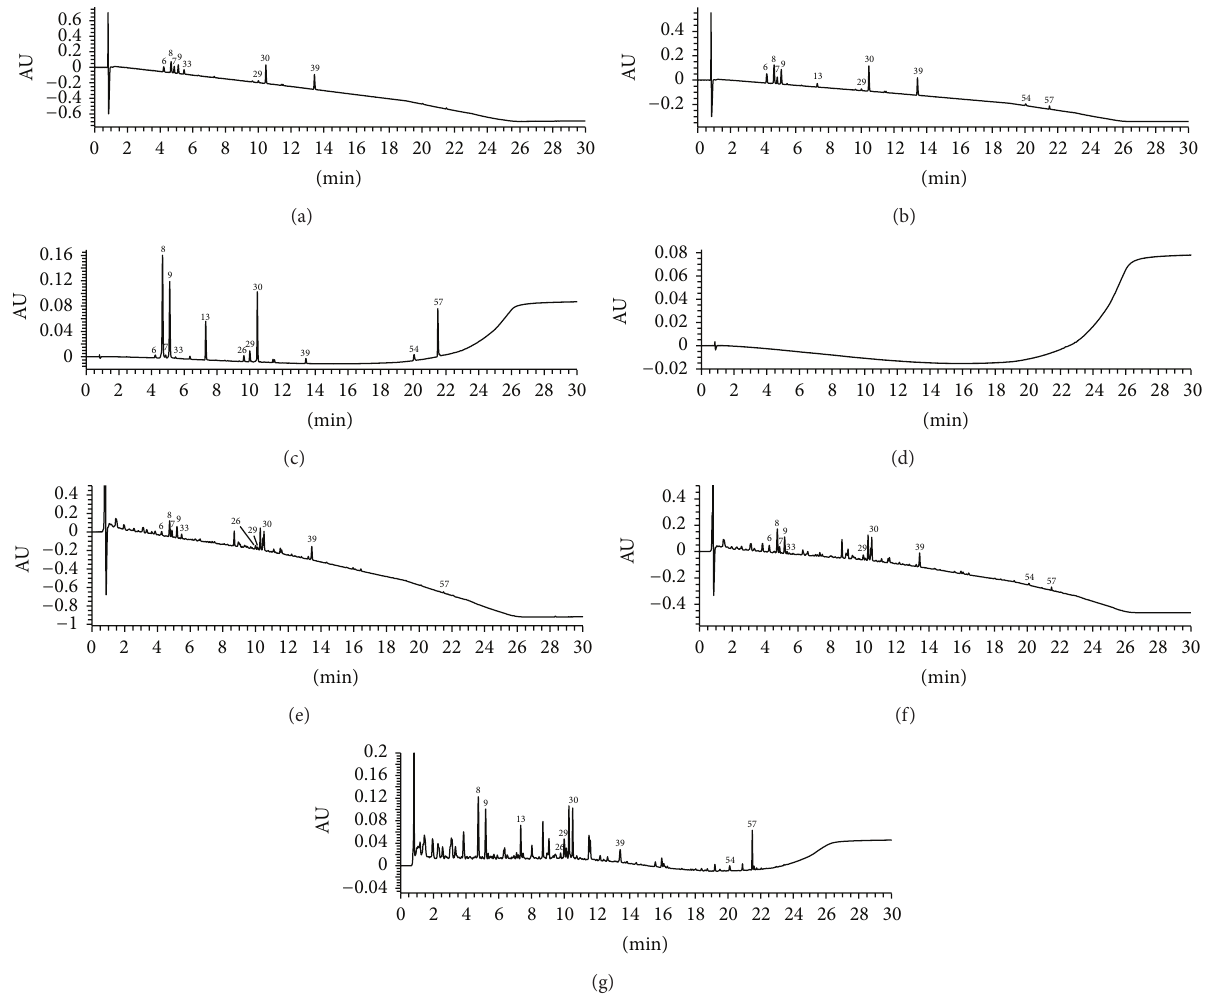
Figure 1: UPLC-DAD chromatograms of standard solution of 210 nm (a), 225 nm (b), 254 nm (c), negative sample solution (d), and sample solution of 210 nm (e), 225 nm (f), and 254 nm (g).